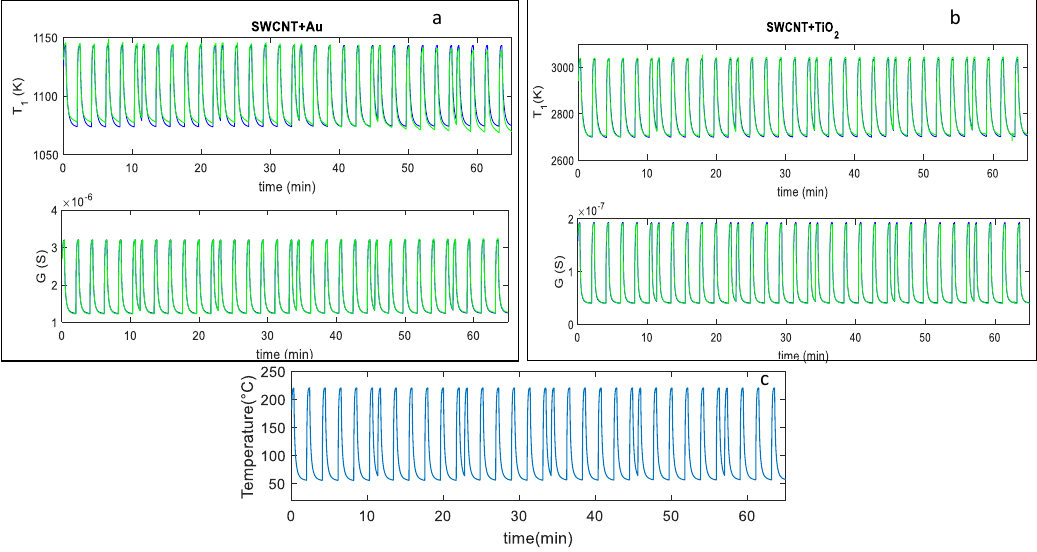
Figure 5. ( a , b ): Blue line-fitting results obtained after parameter estimation for the SWCNT-Au decorated samples ( a ), and the SWCNT-TiO 2 decorated samples ( b ); green lines-measured values; the top plot reports the behavior of the parameter T 1 , whereas the bottom one reports the sensor response G vs. time. The reported results refer to measurements performed in dry synthetic air for approximately 65 min with the temperature profile shown in ( c ). ( c ) measured temperature profile, obtained by repeatedly heating at 220 °C for approximately 0.3 min, and at 60 °C for 1.6 min, respectively (total temperature pulse period t p ≈ 2 min).